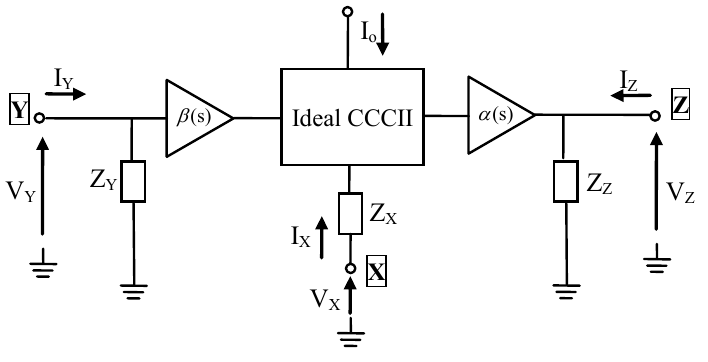
Figure 1. Equivalent circuit of CCCII.